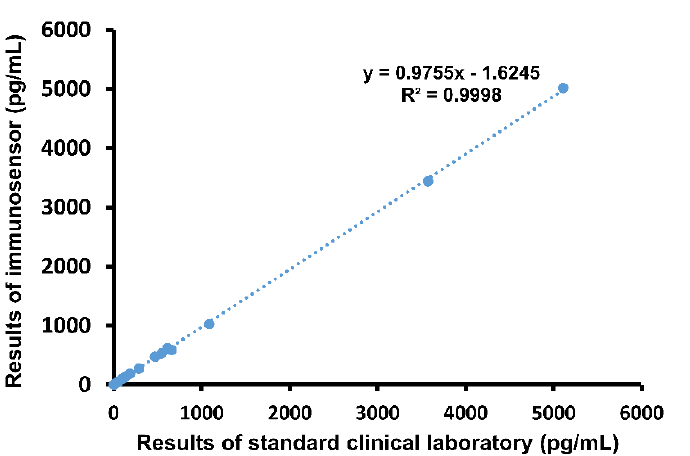
Figure 3. Comparison of immunosensor detection method to standard clinical laboratory detection method in human blood method in human blood samples.